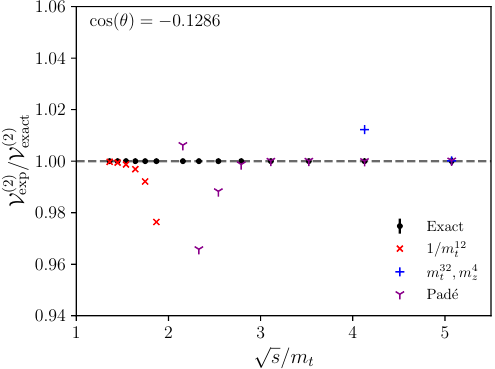
√ Figure 7. Comparison of the s dependence of the unpolarised interference V (2) with expansion for large and small top-quark mass [36] at fixed cos( θ ) = − 0 . 1286